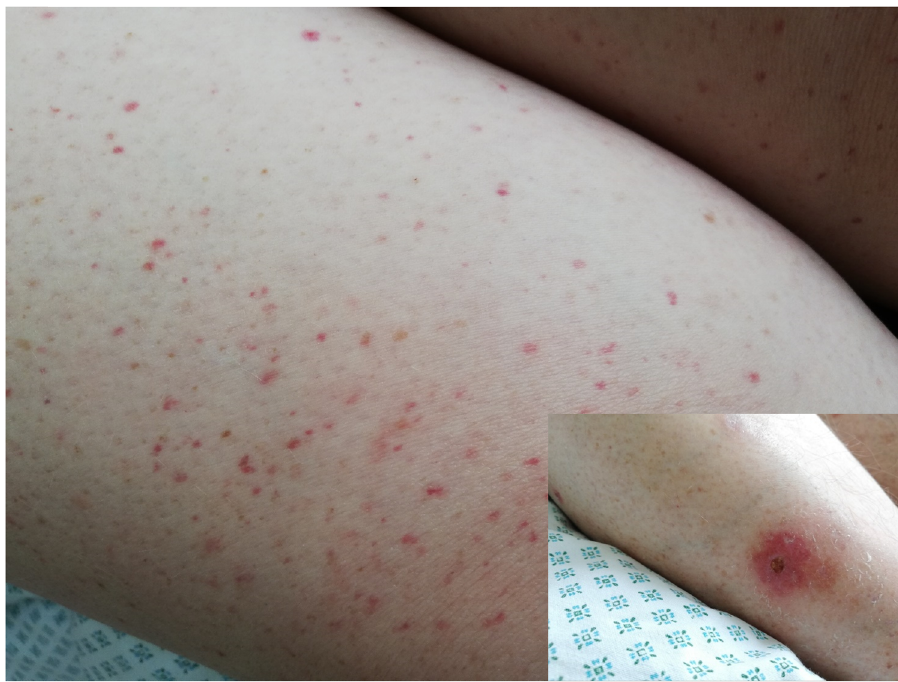
Figure 2: A palpable non - blanching purpuric rash on the right thigh and a sore with necrosis signs on the right shin.